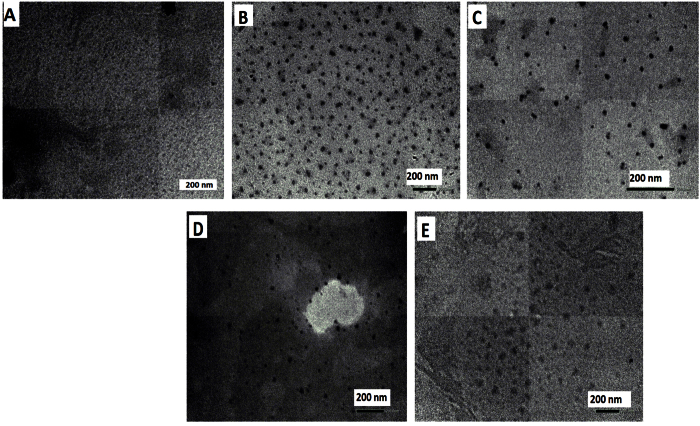
TEM images of the gradient alloyed L-cysteine (A) Cd2.2Zn1.0TeS, (B) Cd2.0Zn1.0TeS, (C) Cd1.8Zn1.0TeS, (D) Cd1.6Zn1.0TeS and (E) Cd1.4.Zn1.0TeS QDs.